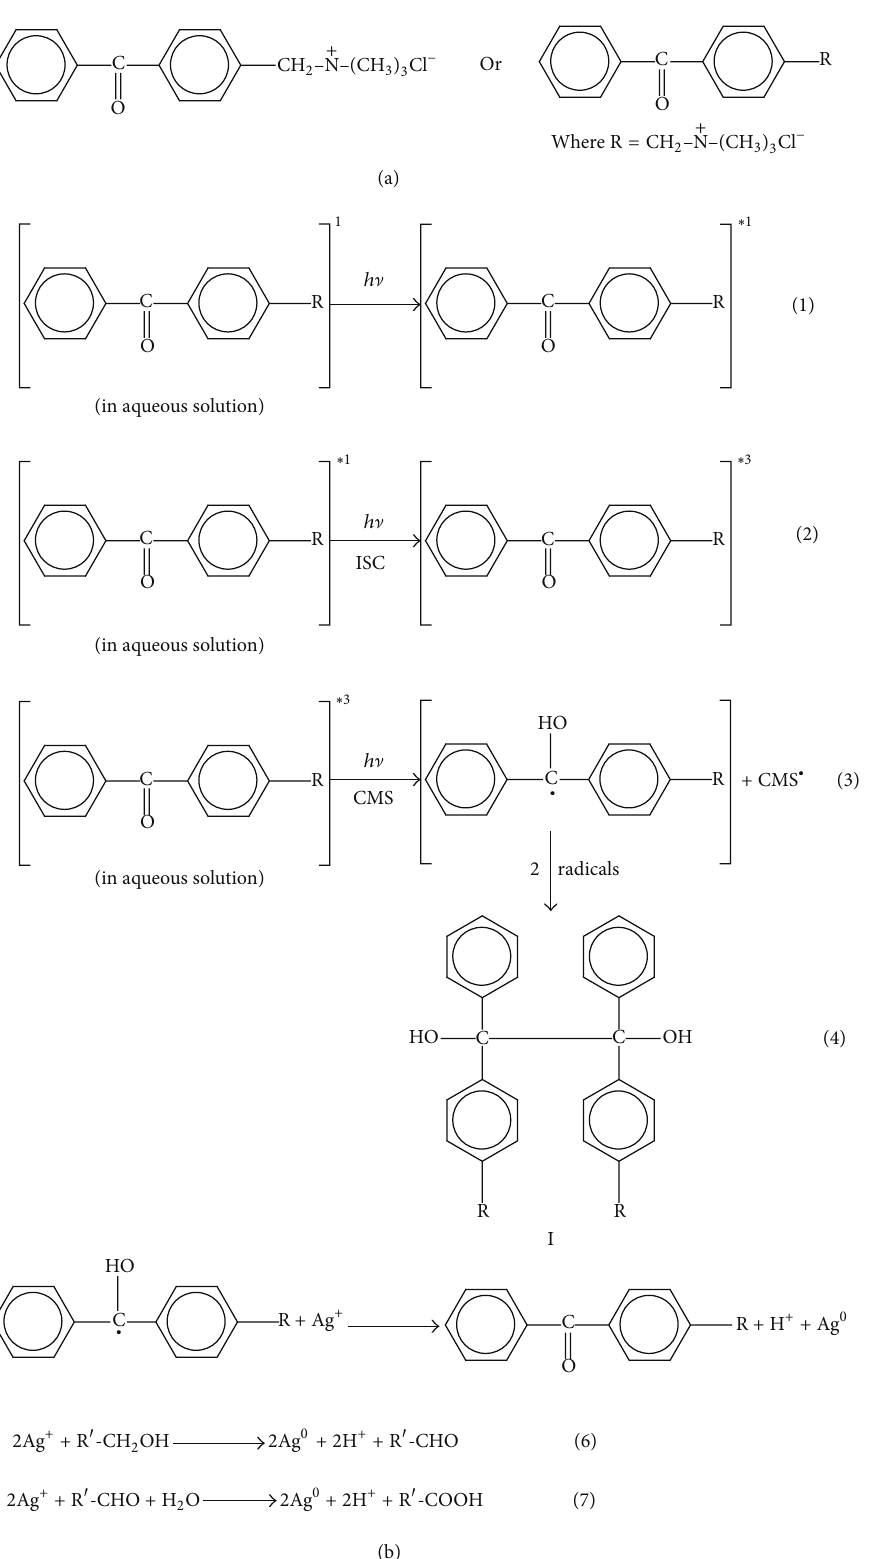
Scheme 1: (a) Chemical structure of PI. (b) Mechanism of photosynthesis of